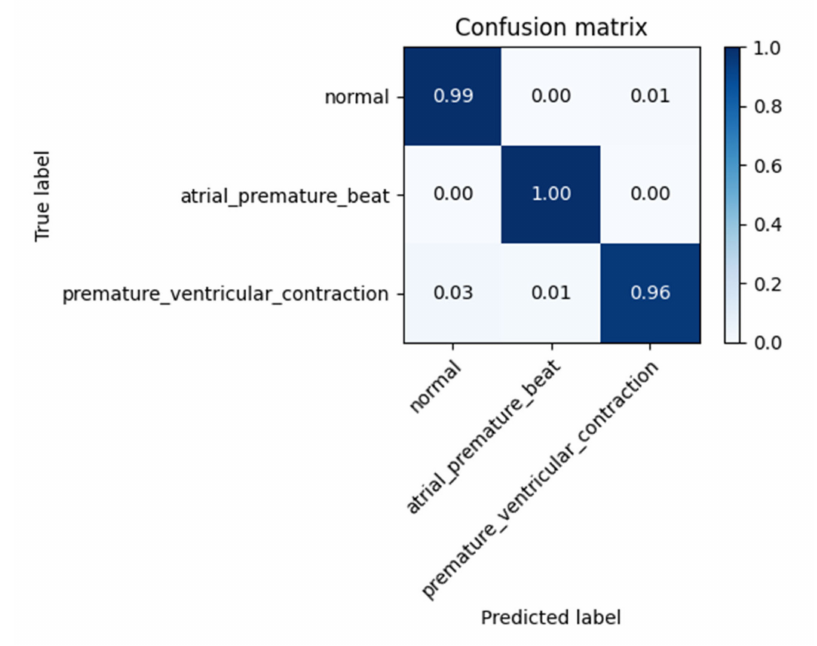
Figure 6. Confusion Matrix for “testing